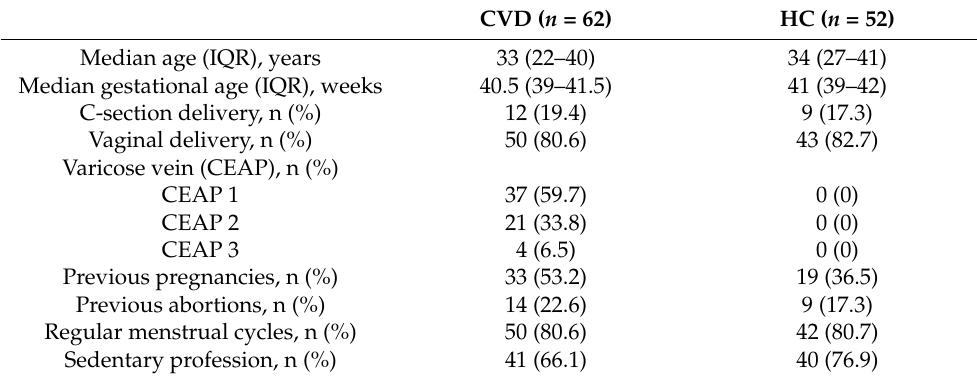
Table 1. Clinical and demographic characteristics. CVD = Chronic venous disease, HC = Healthy